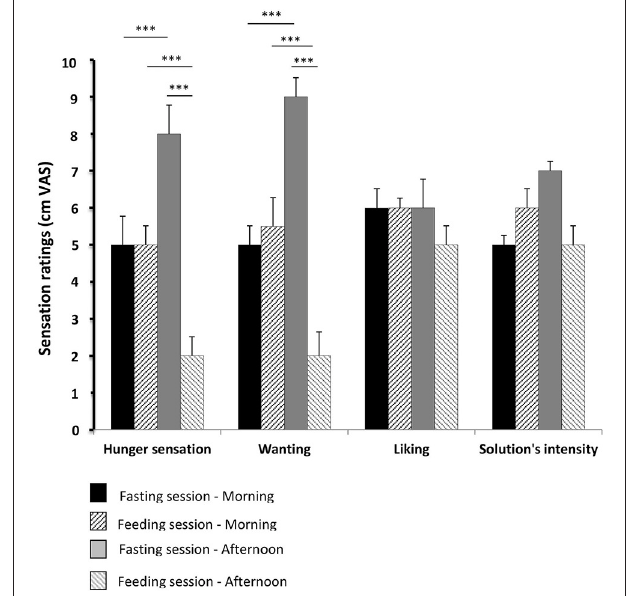
FIGURE 4 | Hunger sensation, wanting, liking, and perceived intensity of the solution. These parameters were evaluated using 10-cm visual analog scales (VAS) for the 15 healthy volunteers evaluated in pre- and post-prandial states in both sessions (feeding and fasting sessions, respectively). The results from the visual analog scales (hunger sensation, wanting, liking, solution intensity) were compared between the feeding and fasting sessions, using a repeated measures ANOVA. A p -value below 0.01 was considered statistically significant (Bonferronni correction). Results are expressed as the mean ± SEM. *** p < 0.001